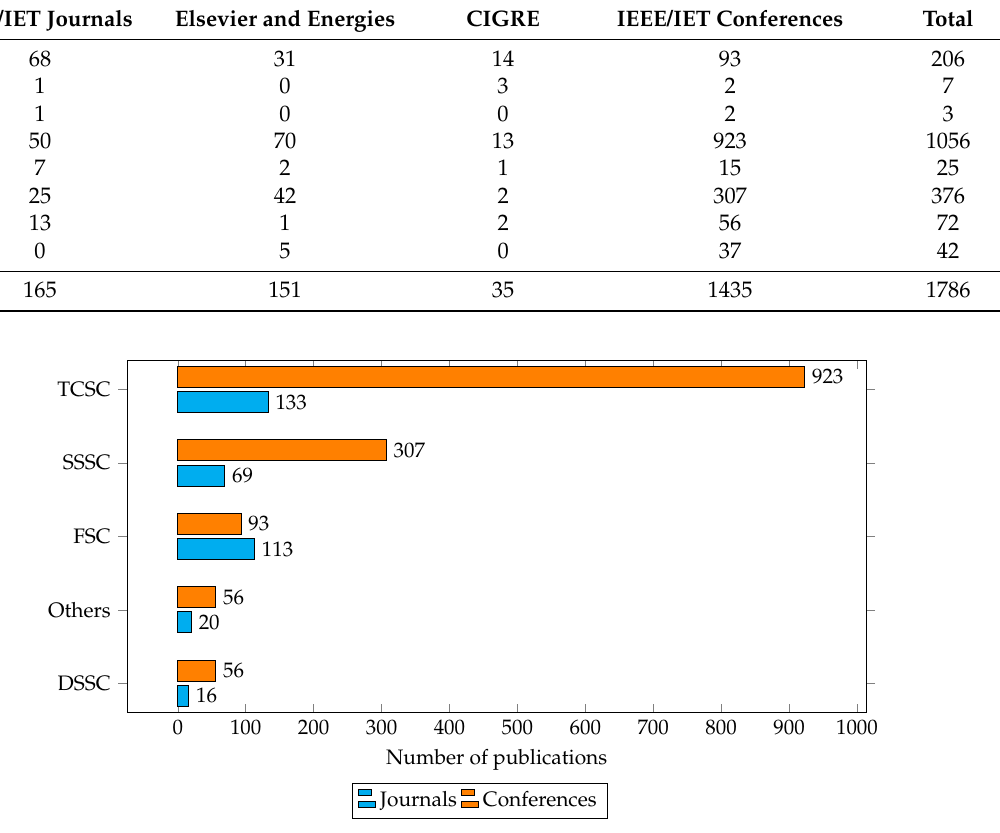
Figure 2. Journal and conference papers published, organized by